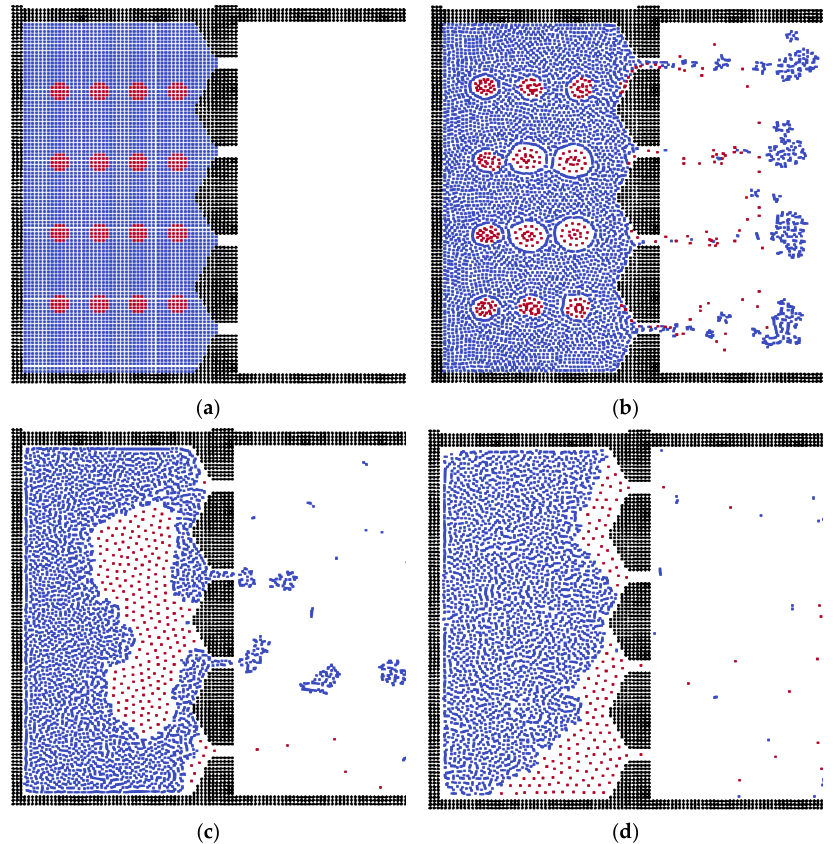
For the triangular membrane structure, the separation result is similar to that of the sphere membrane system. The difference emerges in the final stage: the oil phase forms the oil layer on the membrane surface, stopping further fluid flow, as shown in Figure 4. The reason is that the contact area is controlled by the shape of the membrane. If the shape of the membrane facilitates the connectivity of oil clusters, the oil phase will form an oil layer to block the membrane; otherwise, they will block the channels independently.